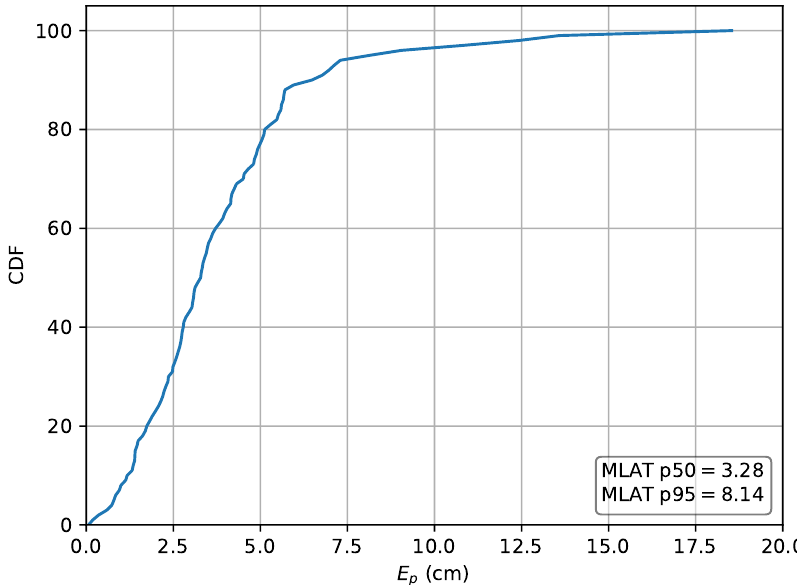
Figure 13. Cumulative distribution of the error evaluated on set A for the absolute multilateration scheme using r as input.